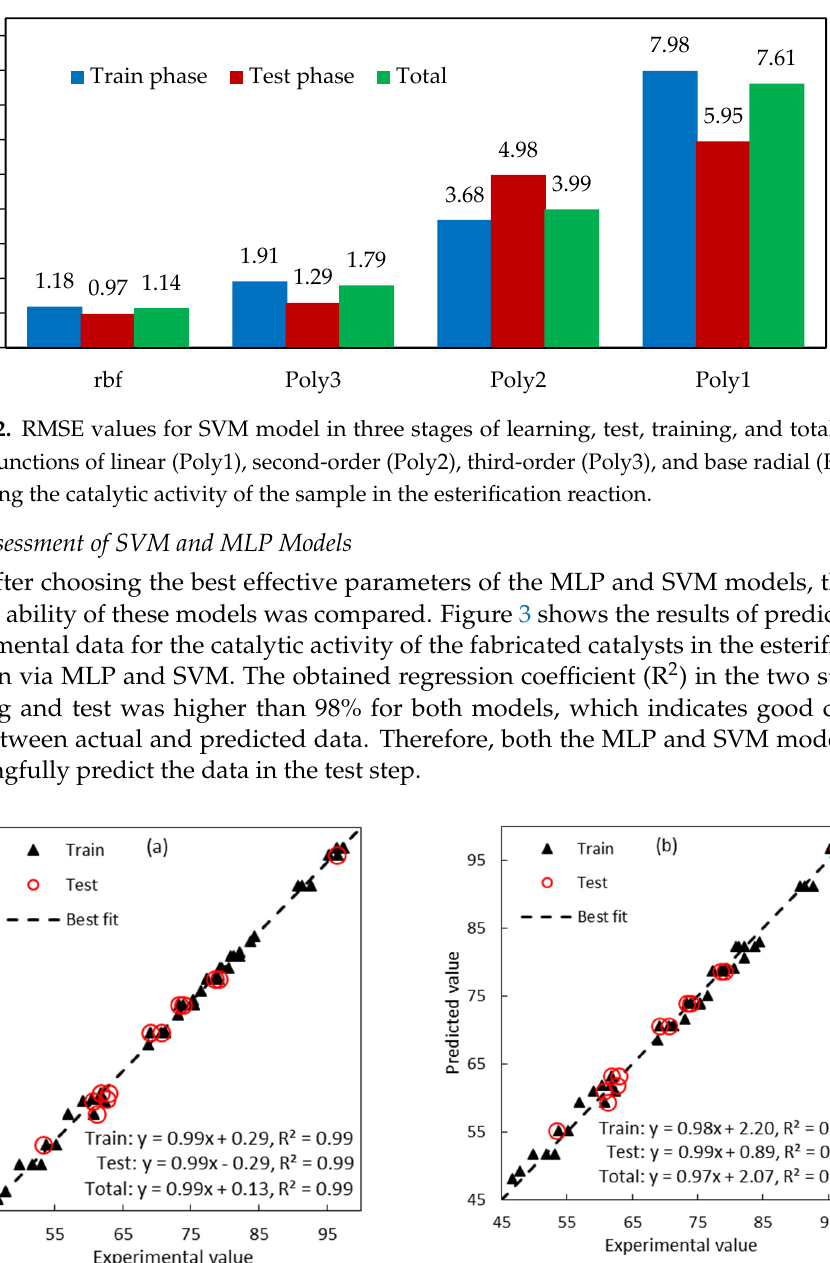
Figure 2. RMSE values for SVM model in three stages of learning, test, training, and total, using kernel functions of linear (Poly1), second-order (Poly2), third-order (Poly3), and base radial (RBF) for modelling the catalytic activity of the sample in the esterification reaction.